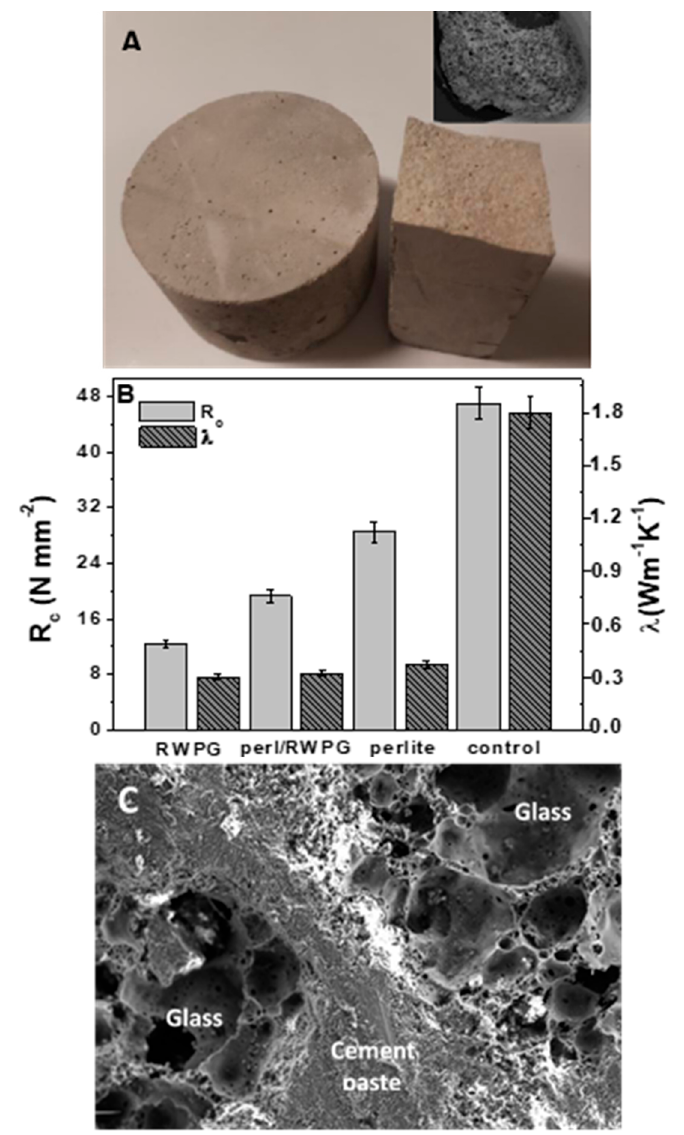
Figure 9. ( A ) Cement mortars with RWPG/perlite mixture as aggregate for thermal measurements (left) and after mechanical tests (right). In the inset: SEM image of a perlite bead. ( B ) Mechanical and thermal tests results for the lightweight mortars and comparison with the sand control. ( C ) SEM image of the cement/RWPG composite.